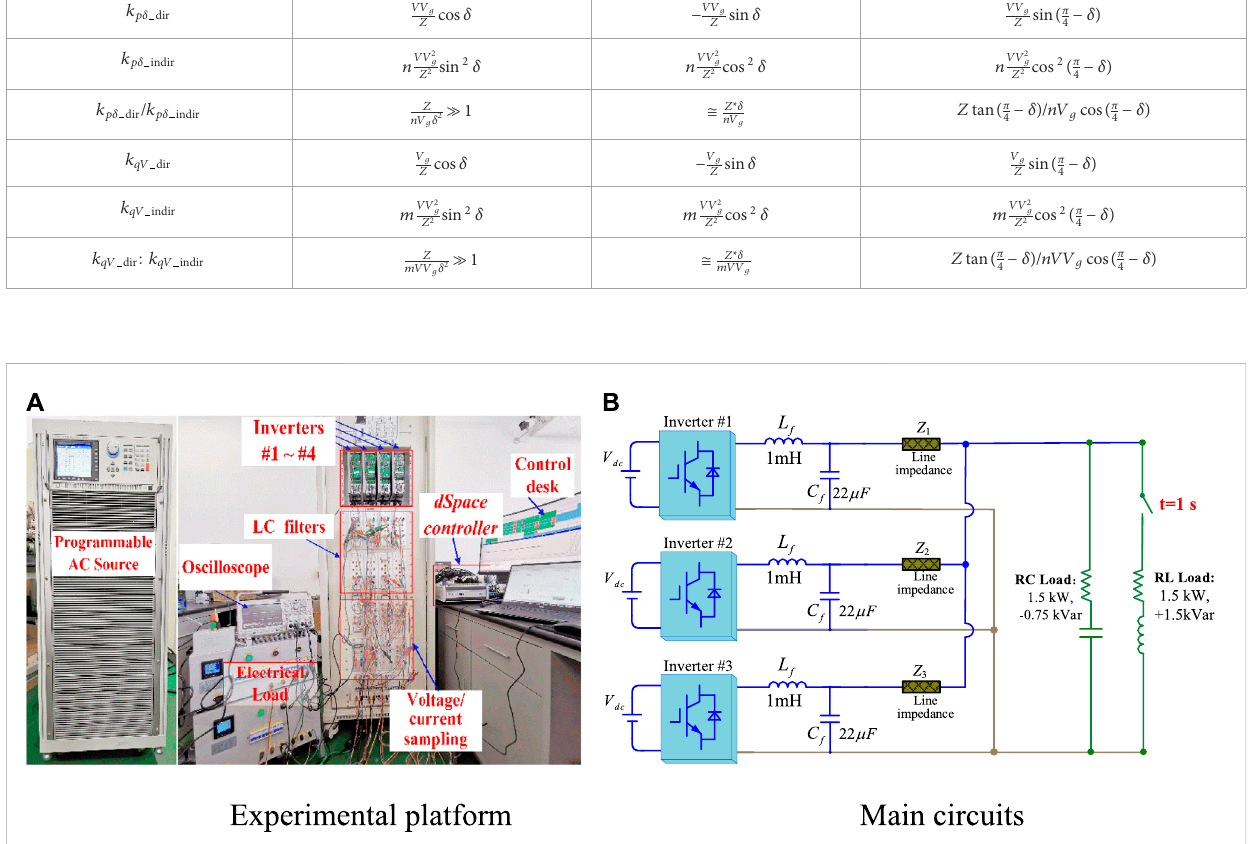
FIGURE 10 Prototype setup of the experiment. (A) Experimental platform; (B) main circuits.